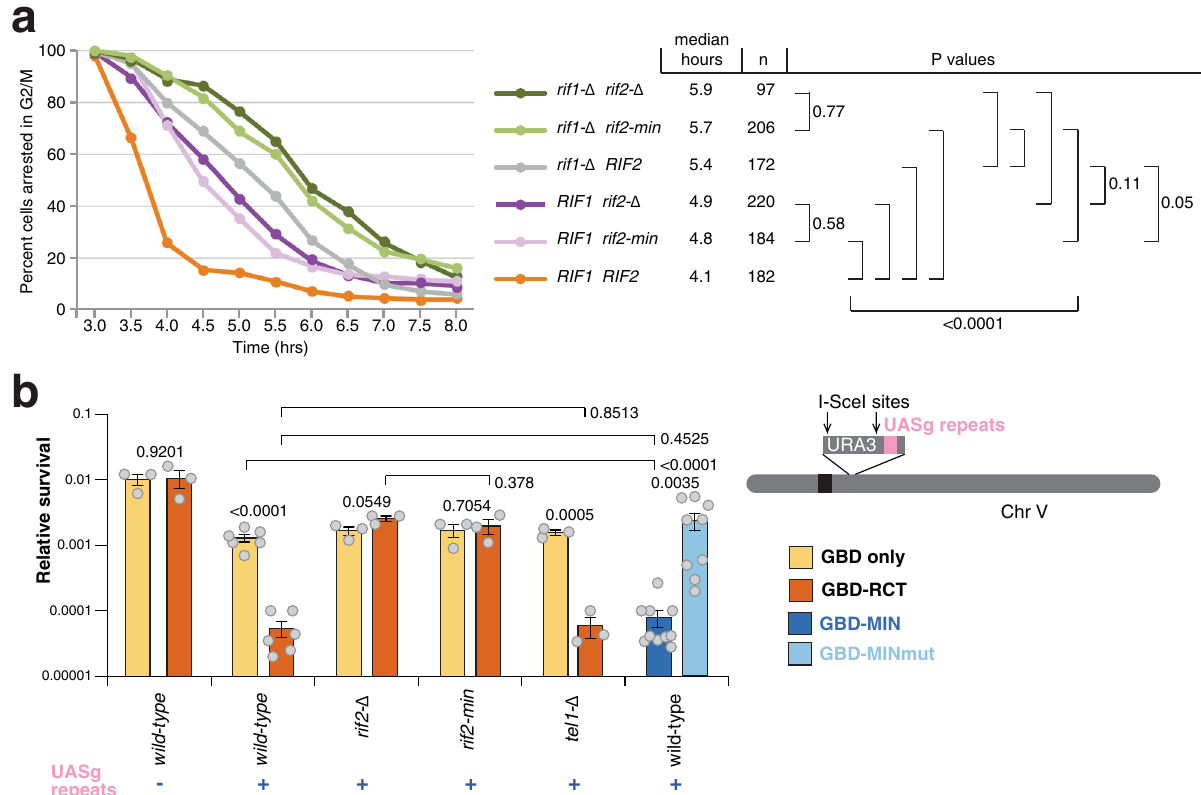
Fig. 3 The MIN motif enforces the suppression of the DDR and NHEJ at a DSB fl anked by telomeric repeats. a A speci fi c DSB, fl anked by telomeric repeat arrays at both ends, was induced at the ADH4 locus on the left arm of chromosome VII by expression of the HO endonuclease in galactose- containing medium. After induction of the break, cells in the S phase were monitored for their ability to escape G2/M arrest. The percentage of G2/M- arrested cells, from at least three independent experiments for each genotype (two for rif1- Δ ), was estimated using the Kaplan – Meier analysis by GraphPad Prism (log-rank test). b Viability assays to quantify the ability of cells to survive a double-inducible DSB on either side of the URA3 gene on chromosome V. Strains were grown in minimal medium lacking uracil and tryptophan, and then plated out on plates containing glucose (to assess plating ef fi ciency) or galactose (to assess survival after cleavage). GBD is Gal4 DNA-binding domain, RCT is the Rap1 C-terminal domain, MIN contains Rif2 amino acids 1 – 40, and the MINmut version carries the F8E P10N mutations. Relative survival was determined from at least three independent experiments; the number of independent cultures analysed was 3, 3, 6, 6, 3, 3, 3, 3, 3, 3, 10, 9 for strains from left to right. Data are presented as mean with SEM. P values are reported for each pair of datasets as indicated and were obtained with a two-tailed, unpaired t test. Source data are provided as a Source Data fi